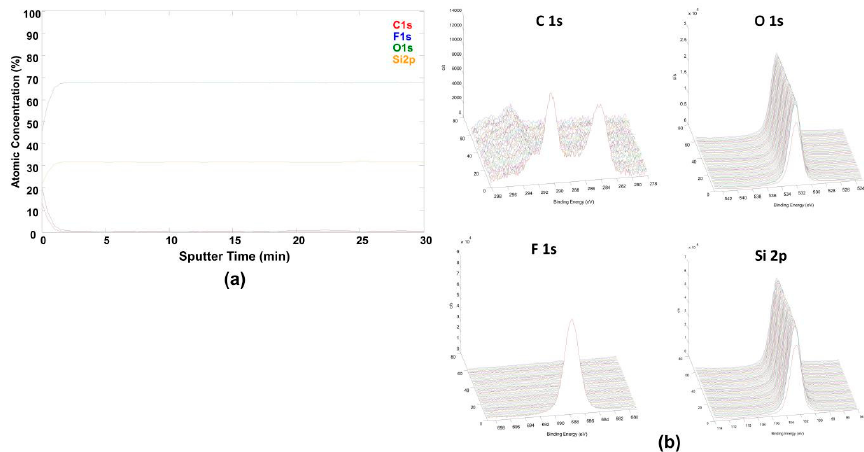
Figure 9. ( a ) Etching curve of four chemical states (C 1s, F 1s, O 1s, and Si 2p) using oxygen gas cluster ion beam (GCIB). ( b ) XPS 3D profiling with a gas cluster ion beam (GCIB), alternating with XPS detection (one layer etching, one layer XPS).